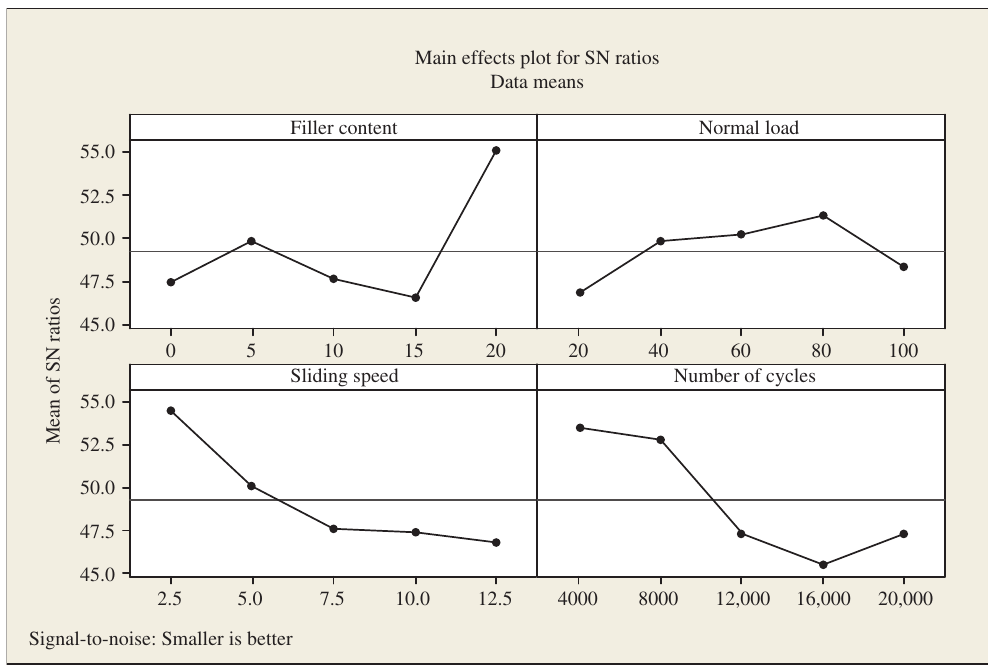
Figure 11: Effect of control factors on the wear rate of marble dust-filled dental